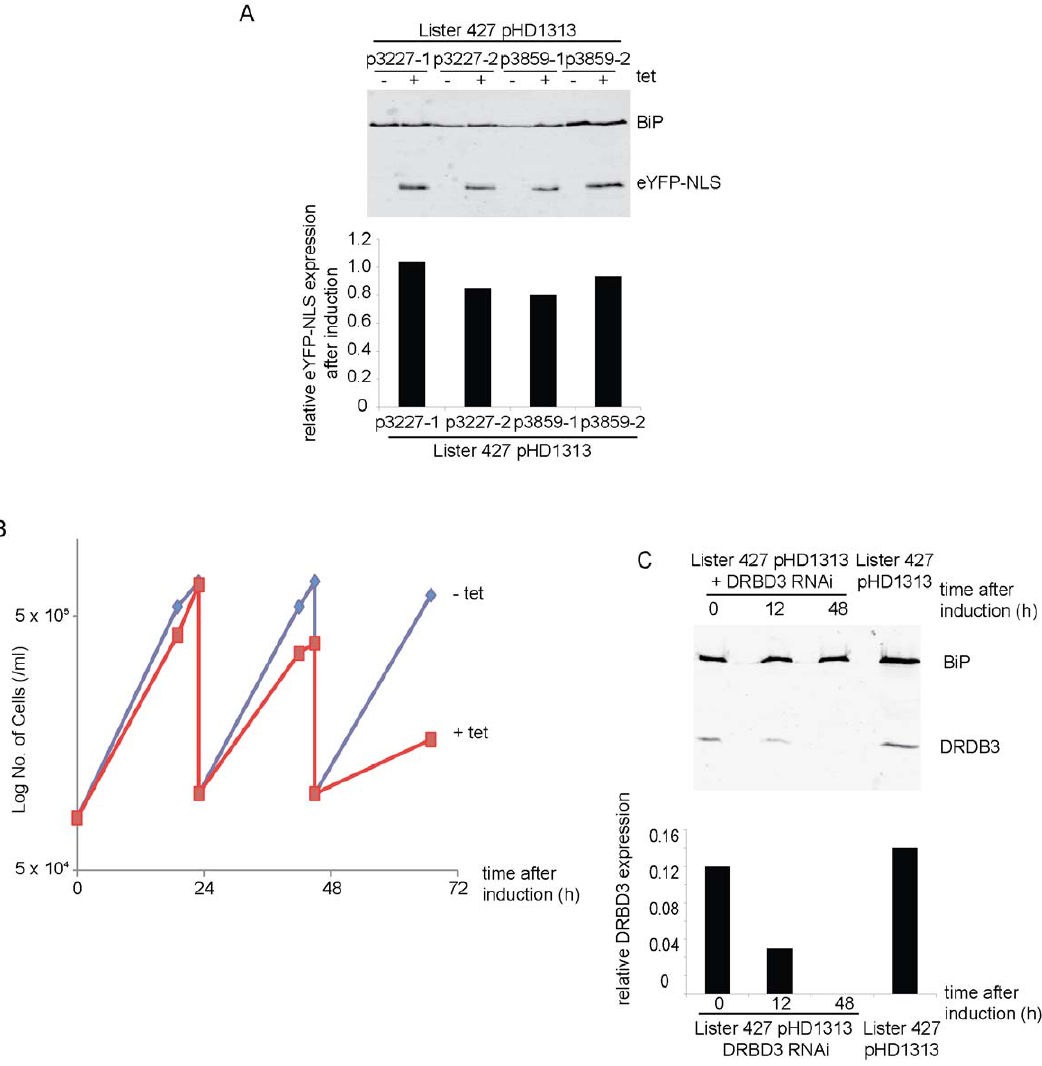
Figure 4. p3666-based RNAi in bloodstream form cells. (A) Western blot probed with anti-GFP showing levels of eYFP-NLS expression in cell lines using either the EP promoter or the rRNA promoter. The expression of eYFP-NLS was normalised against the BiP loading control. Data for two independent clones is shown. (B) Growth of DRBD3 RNAi cell line with or without tetracycline induction. Experiment was repeated with three clones and a representative growth curve is shown. Red line is with induction; blue is without induction. (C) Western blot probed with anti-DRBD3 of samples collected over a time course after addition of tetracycline. The levels of DRBD3 expression were normalised against the BiP loading control. Experiment was repeated with three clones and a representative Western blot and quantitation is